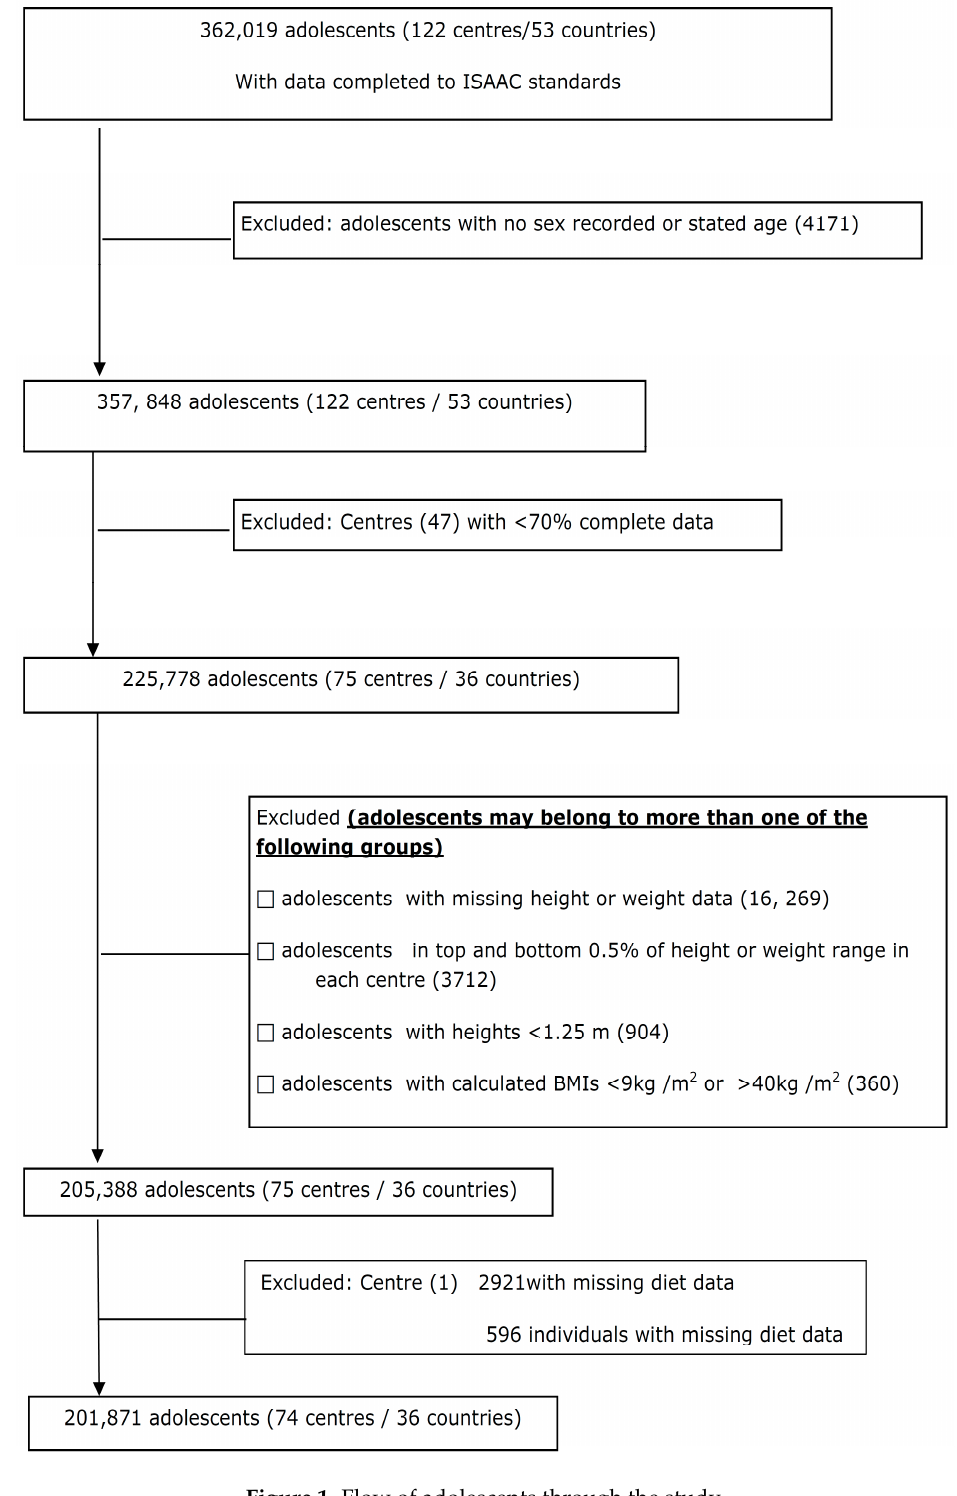
Figure 1. Flow of adolescents through the study.